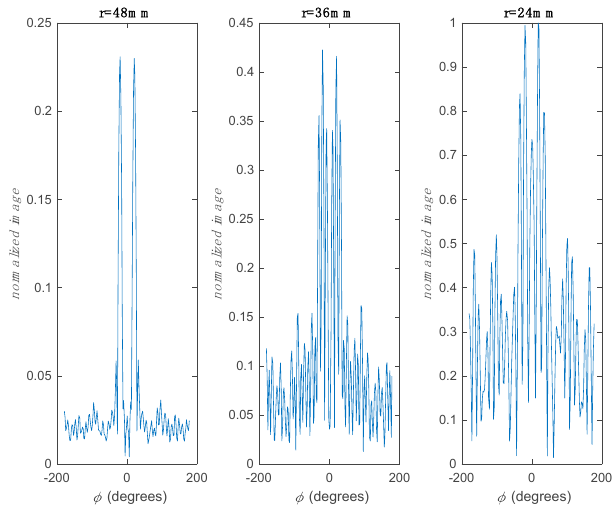
Figure 6. Normalized 2D reconstructed image of objects with a side of D = 10 mm on three imaged circles with radii of 48, 36 and 24 mm using double frequency data collected by eight receiver antennas.